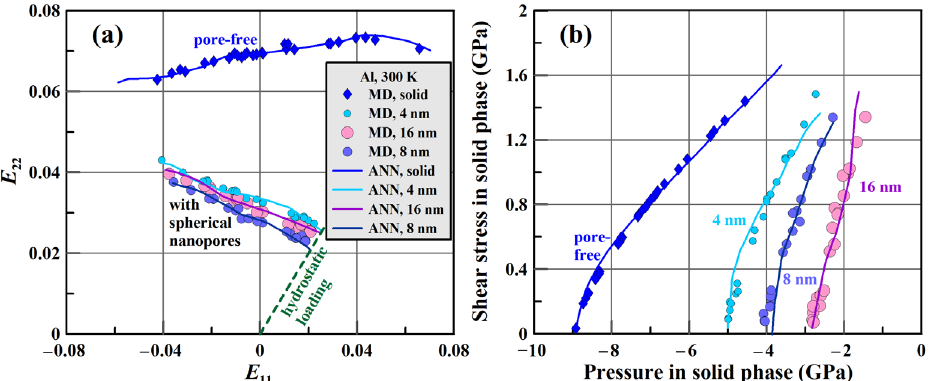
Figure 7. Threshold of dislocation nucleation at tension of nanoporous aluminum with spherical pores with different diameters in comparison with the case of pore-free aluminum. Symbols showing MD data and lines showing the ANN-based prediction for the nucleation threshold are plotted ( a ) in the deformation space { E 11 , E 22 } and ( b ) as the dependencies of the critical shear stress in the solid phase on the pressure in the solid phase. The temperature is 300 K.